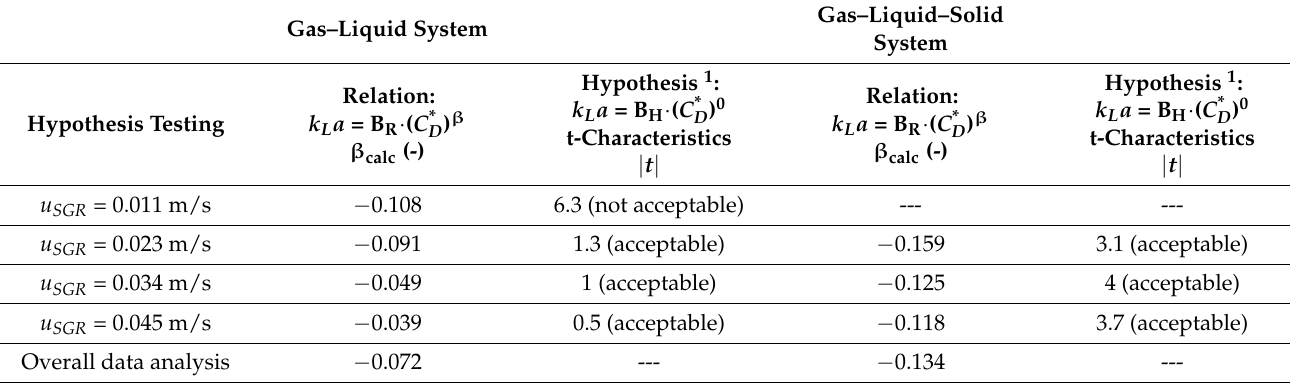
Table 15. Overall volumetric mass transfer coefficient k L a : Results of the hypothesis testing-effect of deflector clearance C D on superficial gas velocity u SGR = const.